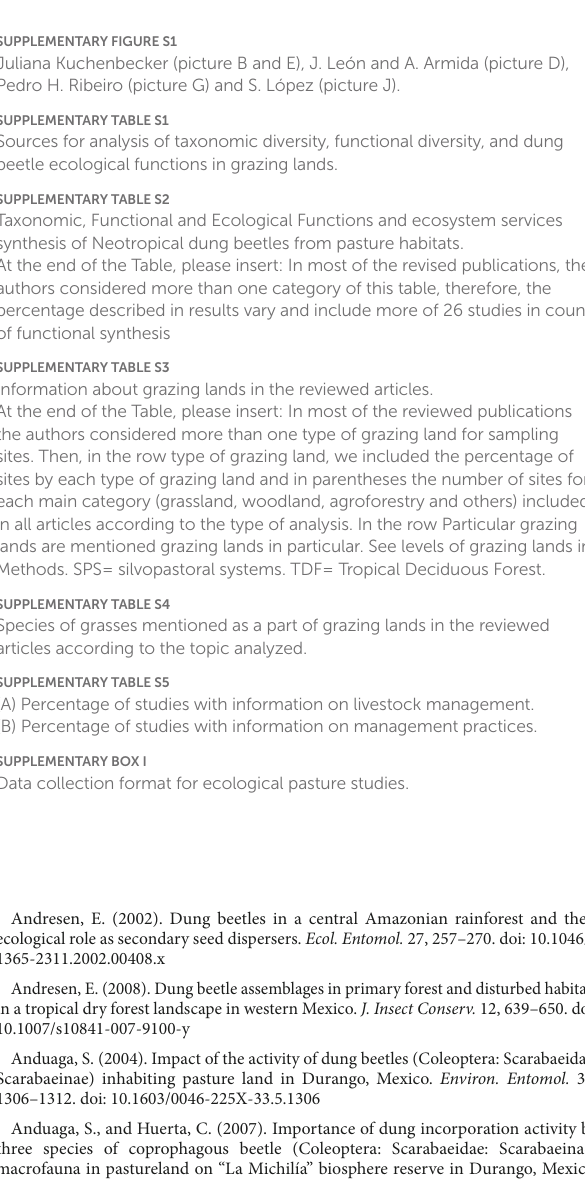
SUPPLEMENTARY FIGURE S1 Juliana Kuchenbecker (picture B and E), J. León and A. Armida (picture D), Pedro H. Ribeiro (picture G) and S. López (picture J). SUPPLEMENTARY TABLE S1 Sources for analysis of taxonomic diversity, functional diversity, and dung beetle ecological functions in grazing lands.